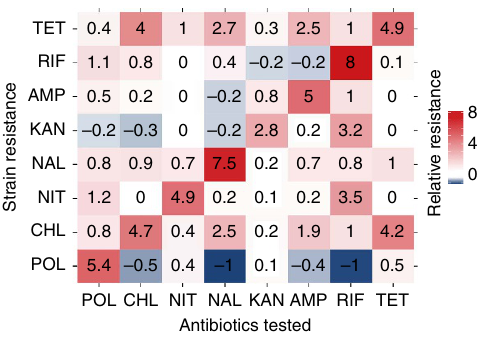
Figure 2 | The collateral sensitivity and cross resistance profile of resistant strains. MICs of the final day samples from the evolution experiments under single antibiotic conditions were tested with all eight antibiotics. Blue and red grids indicate that the antibiotic pair is collateral sensitive and cross resistance, respectively. The numbers in the grids are log 2 -transformed MIC fold change. The values shown in the matrix were rounded. See Supplementary Table 2 for the original